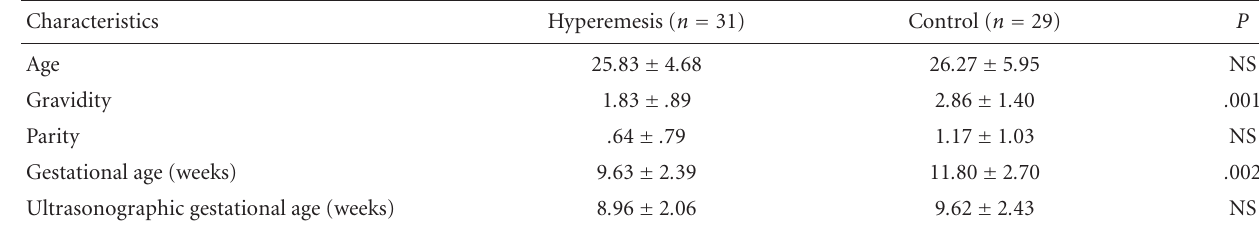
Table 1: Demographic characteristics.